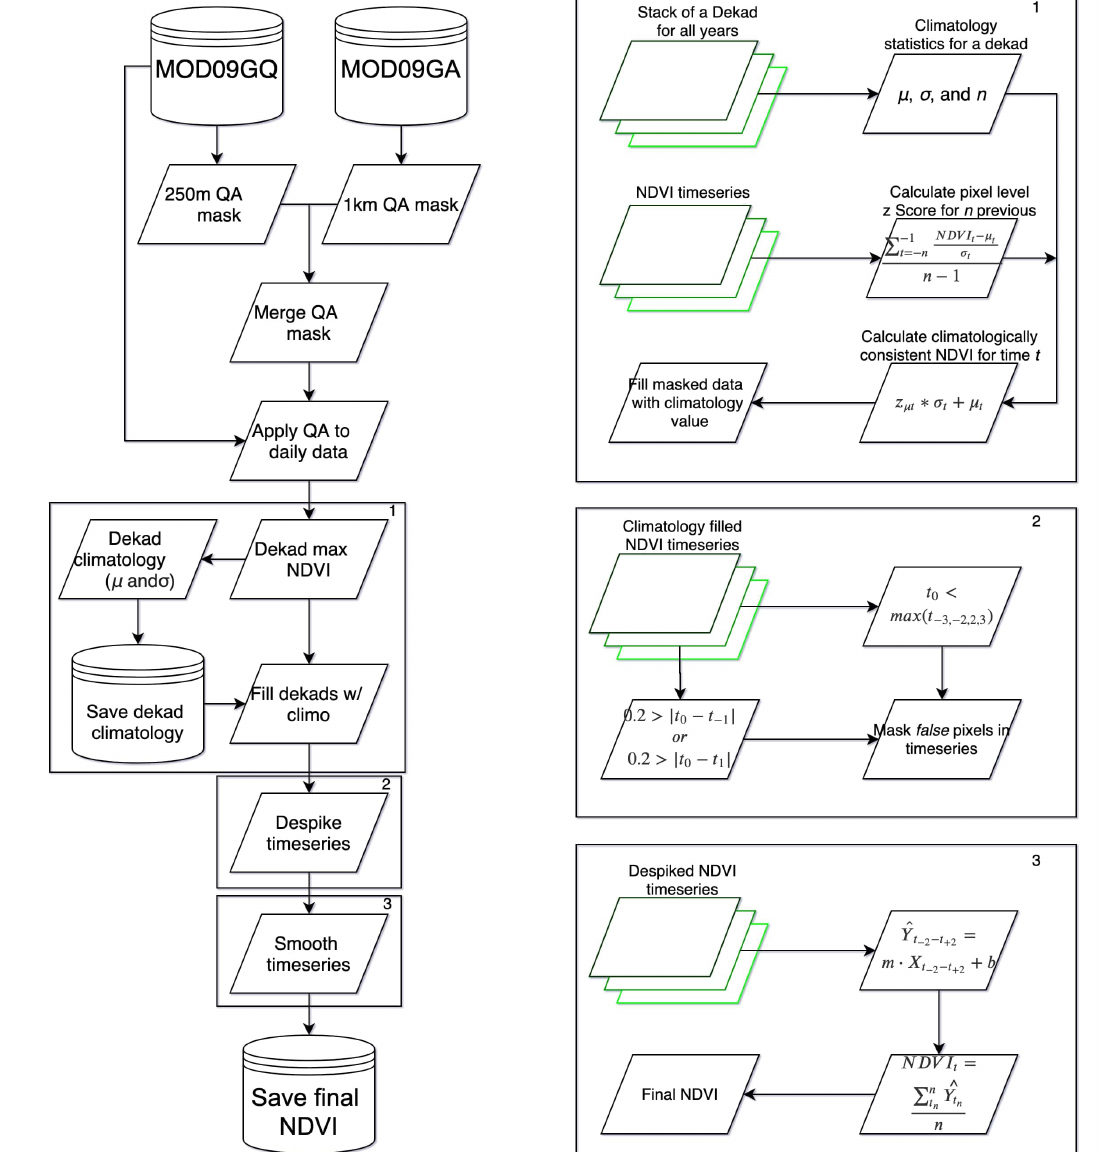
Figure 2. Flowchart schematic for creating the rapid enhanced NDVI (reNDVI) dataset. An overarching flowchart is provided on the left, and specific information on component processing is provided on the